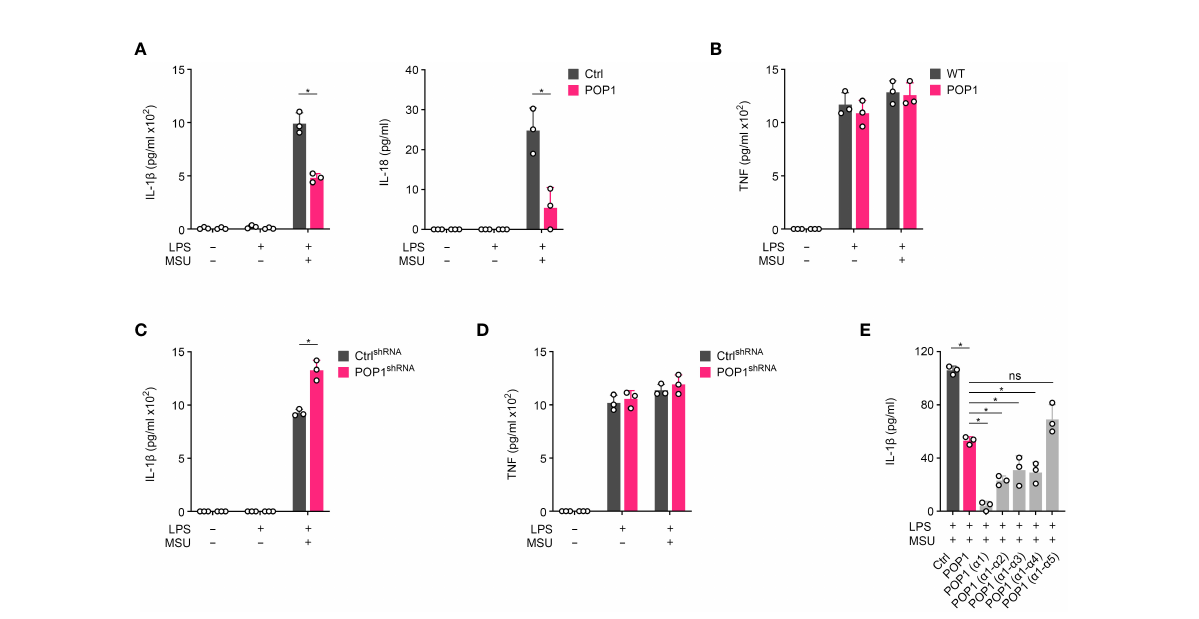
FIGURE 5 POP1 inhibits in fl ammasome-dependent cytokine release in human macrophages. (A, B) Control (Ctrl) and POP1 expressing THP-1 cells (POP1) were primed with LPS and treated with MSU crystals as indicated and culture supernatants (SN) were analyzed for secreted (A) IL-1 b and IL-18 and (B) TNF by ELISA (n = 3 ± s.d.). (C, D) Ctrl shRNA and POP1 shRNA expressing THP-1 cells were primed and treated with MSU crystals as above and culture SN were analyzed for secreted (C) IL-1 b and (D) TNF by ELISA (n = 3 ± s.d.). (E) LPS primed Control (Ctrl) THP-1 cells or THP- 1 cells stably expressing POP1 or the indicated a helices of POP1 were activated with MSU crystals and culture supernatants were analyzed for secreted IL-1 b by ELISA (n = 3 ± s.d.). *p < 0.05, ns, non speci fi